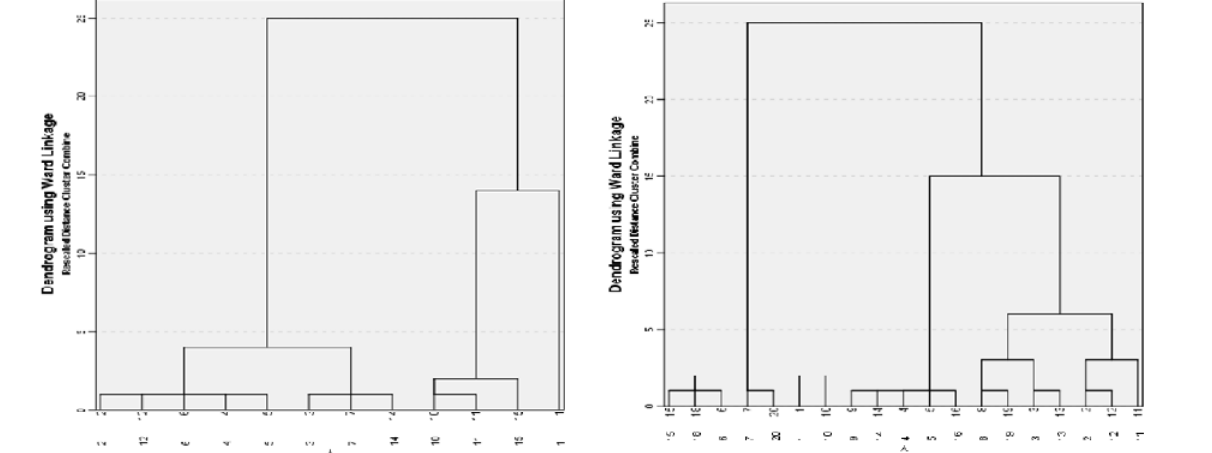
Fig. 5: Dendrogram for Omani bottled drinking water brands Fig. 6: Dendrogram for UAE bottled drinking water brands